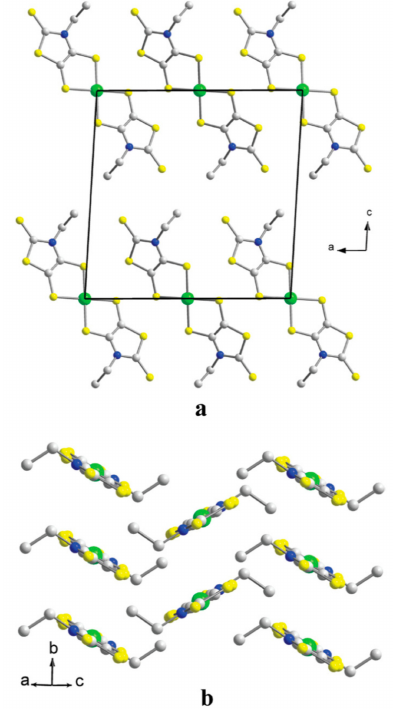
Figure 7. Two-dimensional molecular arrangement in the crystals of Au(Et-thiazdt) 2 : ( a ) view along the b -axis; ( b ) view along the 101-direction. For Et-thiazdt, see Figure 4. The molecules interact with each other in an isotropic way in the ab -plane, resulting in a sheet structure in the ab -plane. Reproduced from Ref. [49] with permission. Copyright 2009, American Chemical